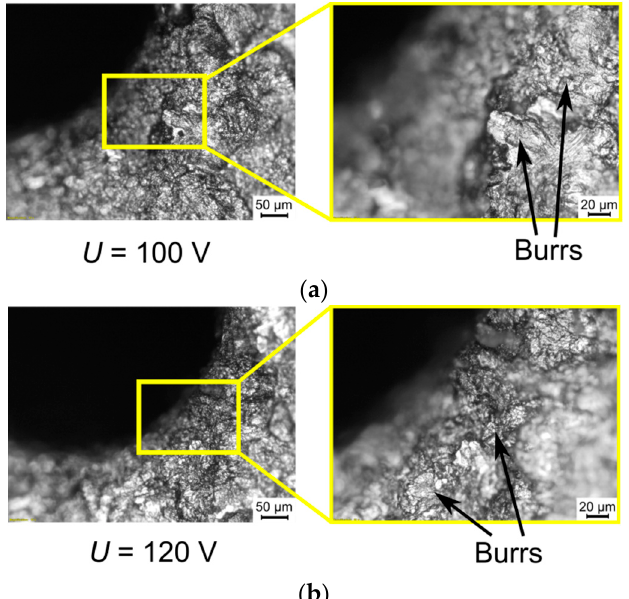
Figure 12. The edge of entrance diameter of micro-hole fabricated by various values of the open voltage: ( a ) U = 100 V; and ( b ) U = 120 V; the other machining parameters: t on = 550 µs, I = 3.33 A, p = 7 MPa, n = 300 rpm.